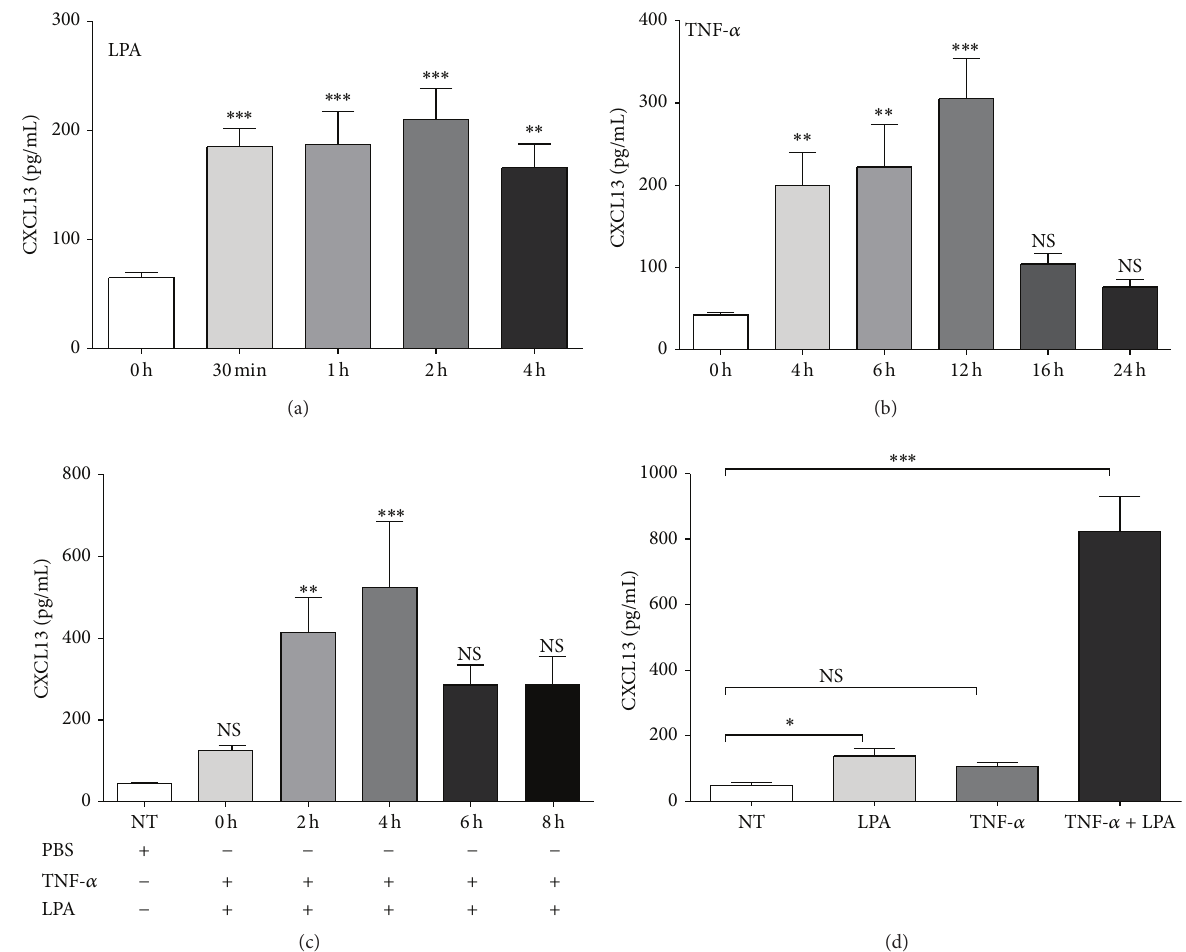
Figure 2: Effect of LPA and TNF- 𝛼 on CXCL13 secretion in the air pouch. (a), (b) Kinetics of LPA and of TNF- 𝛼 -mediated CXCL13 secretion. (a) LPA (3 𝜇 g) or (b) TNF- 𝛼 (50ng) was injected into air pouches and air pouch exudates were collected at indicated times. (c) Kinetics of LPA-induced CXCL13 secretion in air pouches pretreated with TNF- 𝛼 . TNF- 𝛼 was injected 16h before LPA stimulation. Air pouch exudates were collected at indicated times. (d) Comparison of LPA-mediated CXCL13 secretion in untreated and TNF- 𝛼 -primed air pouches. TNF- 𝛼 or vehicle was injected 16h prior to administration of LPA for 2h. Exudates were collected and cytokine/chemokine secretion was measured by ELISA. The nontreated (NT) groups were injected with vehicle only (PBS-BSA). Data are the mean ± SE from three independent experiments performed with at least five mice per group. ∗ 𝑃 < 0.05 , ∗∗ 𝑃 < 0.01 , and ∗∗∗ 𝑃 < 0.001